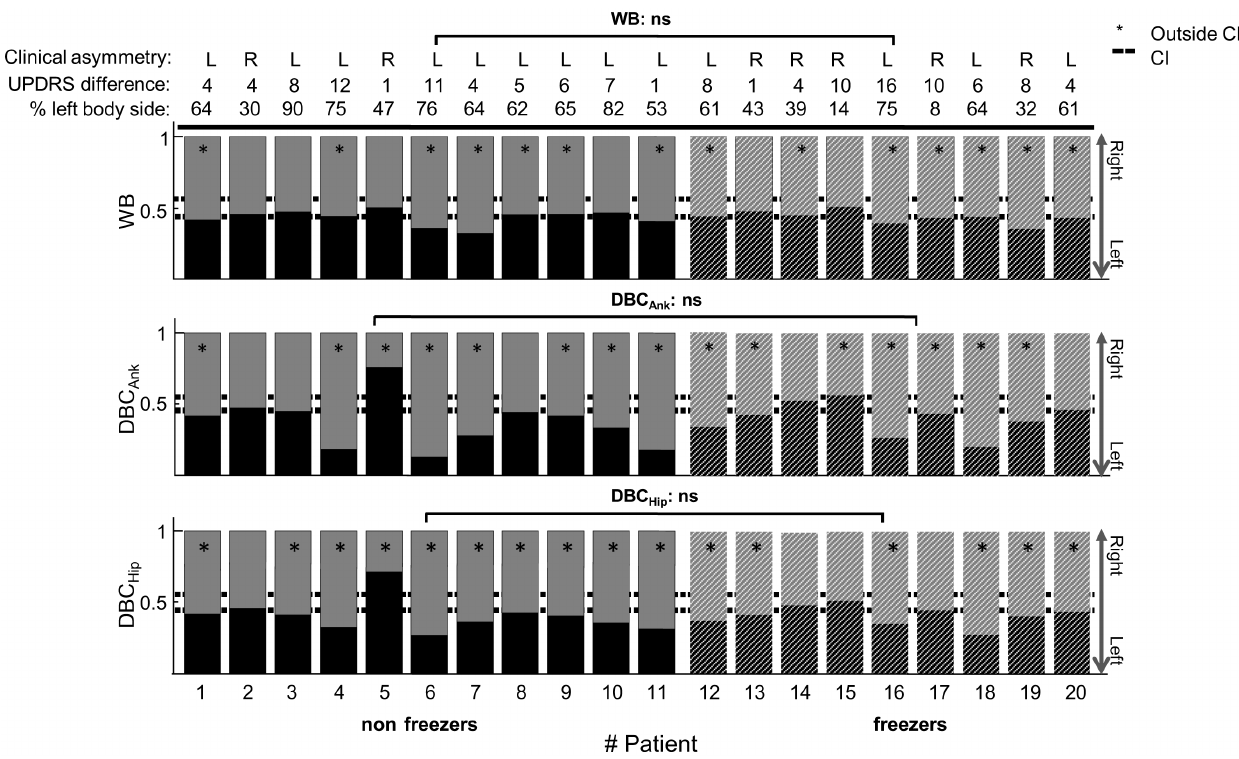
Figure 4. Clinical asymmetry, weight-bearing and balance-control contribution of the left (lower bar) and right leg (upper bar) of the individual PD patients. The absolute and relative value and the most affected side of the clinical asymmetry is shown above the bar graphs. The upper panel indicates the dynamical weight bearing (DWB), the middle panel the dynamic-balance contribution of the ankle joint (DBC Ank ), and the lower panel is of the hip joint (DBC Hip ). The group is separated in non-freezers (the first 11 patients, indicated by the solid bars) and freezers (patient 12 through 20, indicated by the dashed bars). There were no significant differences in asymmetry of WB, DBC Ank nor DBC Hip between non- freezers and freezers. The dashed line indicate the 99-percent confidence intervals of the healthy controls for the WB, DBC Ank, and DBC Hip . The asterisk (*) denotes balance contributions outside the respective confidence intervals. For WB, 14 patients were outside the 99 percent CI. This number increased to 15 considering DBC Ank and to 16 for DBC Hip . ns=not significant. The clinically most affected side coincided in most cases with weight- bearing and balance-control asymmetry. However, there were no significant correlations between clinical asymmetry and balance asymmetry (WB, p=0.32; DBC Ank , p=0.37 and DBC Hip , p=0.75).